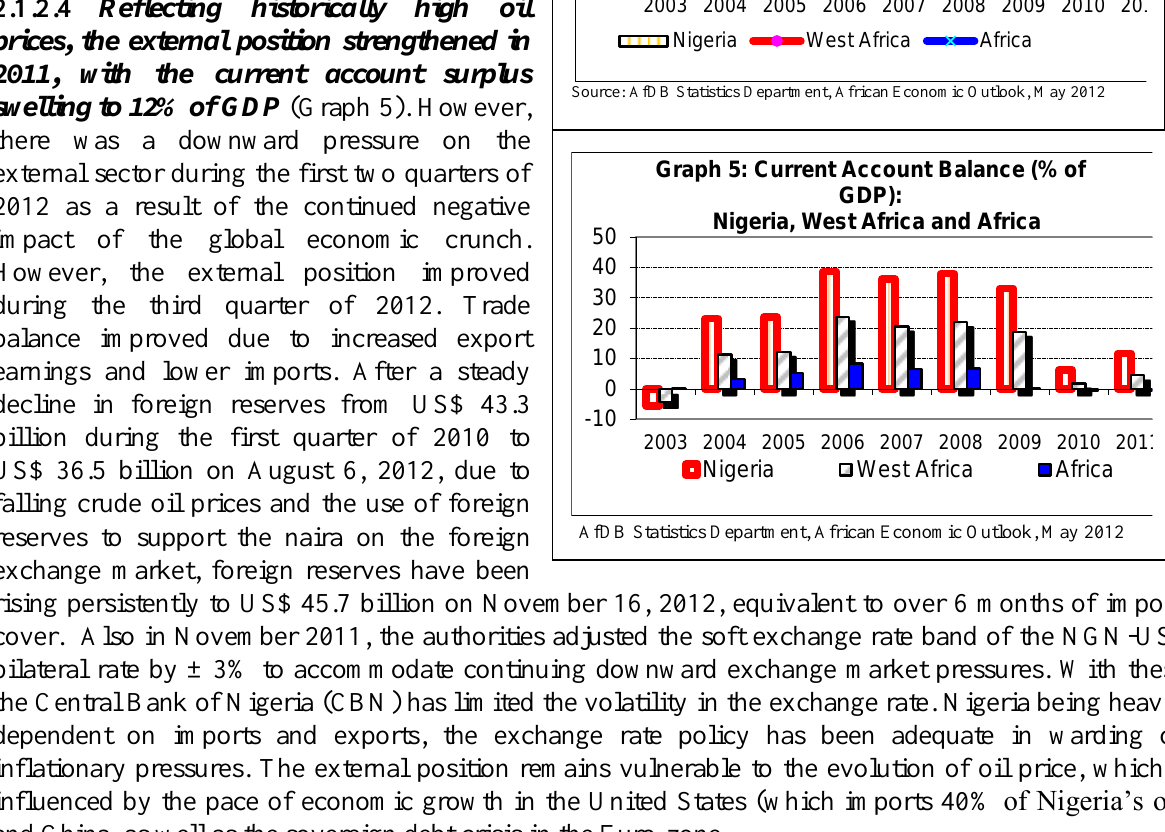
Graph 4: Consumer Price Index, Inflation (Average) (%)